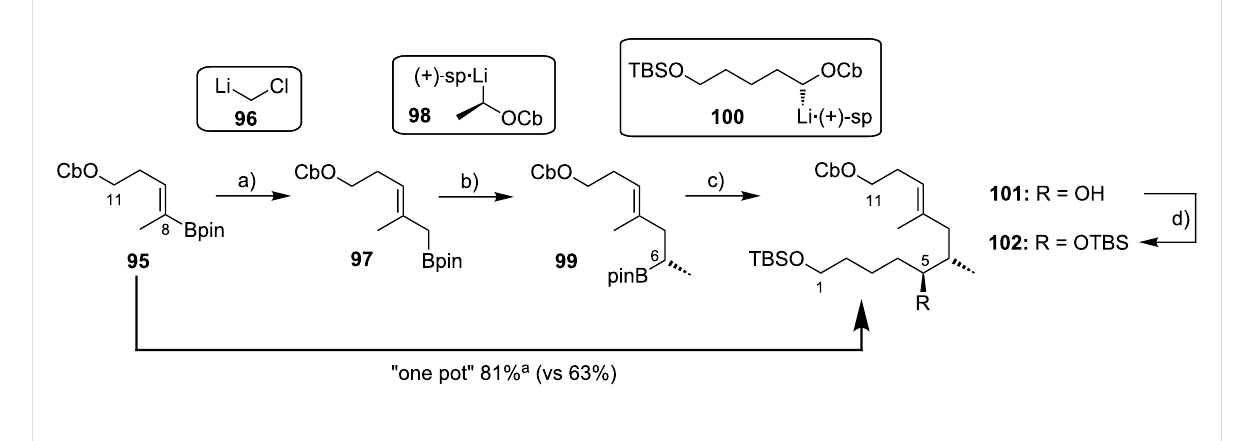
Scheme 10: Aggarwal’s synthesis of the C1–C11 fragment of the mycolactone core. Reagents and conditions: a) ClCH 2 I, n- BuLi, Et 2 O, − 95 °C, 99%; b) EtOCb, (+)-sparteine, s- BuLi, Et 2 O, − 78 °C, then 97 , − 78 °C to 40 °C, 83%, er 97:3; c) (i) 5-TBSO-pentyl-OCb, (+)-sparteine, s- BuLi, Et 2 O, − 78 °C,